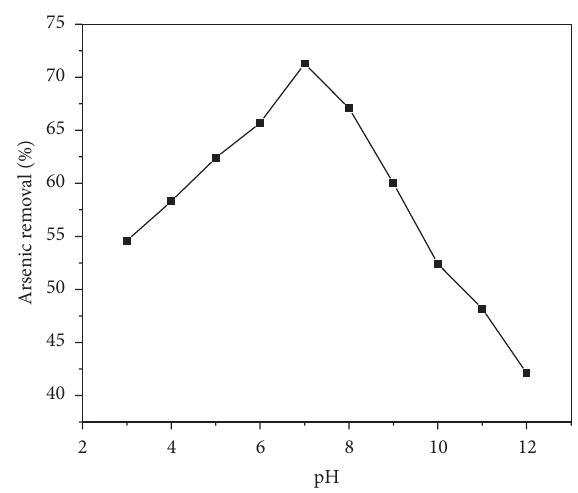
Figure 3: Effect of pH on biosorption of arsenic.